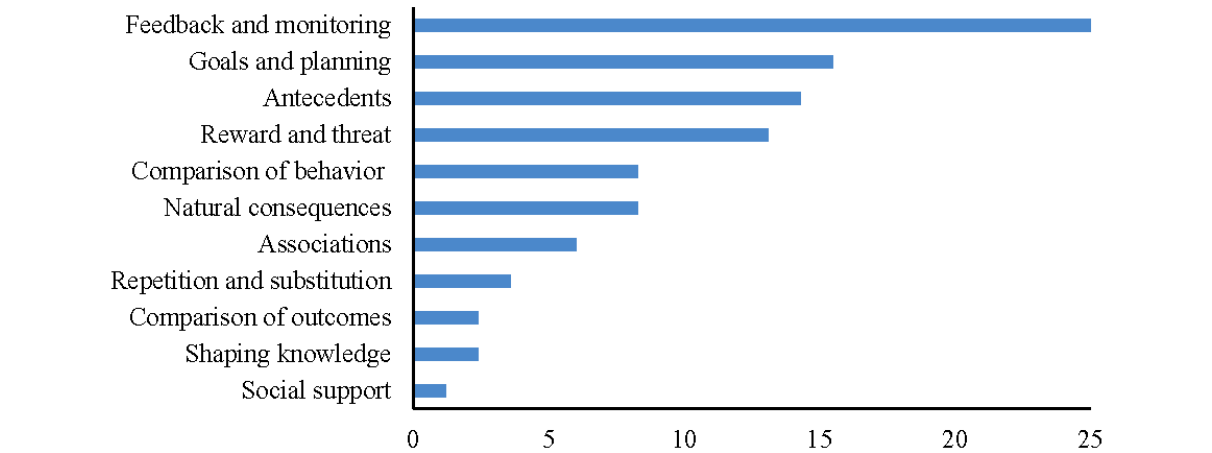
Figure 2. Mean percentage of behavior change technique clusters incorporated across all fitness